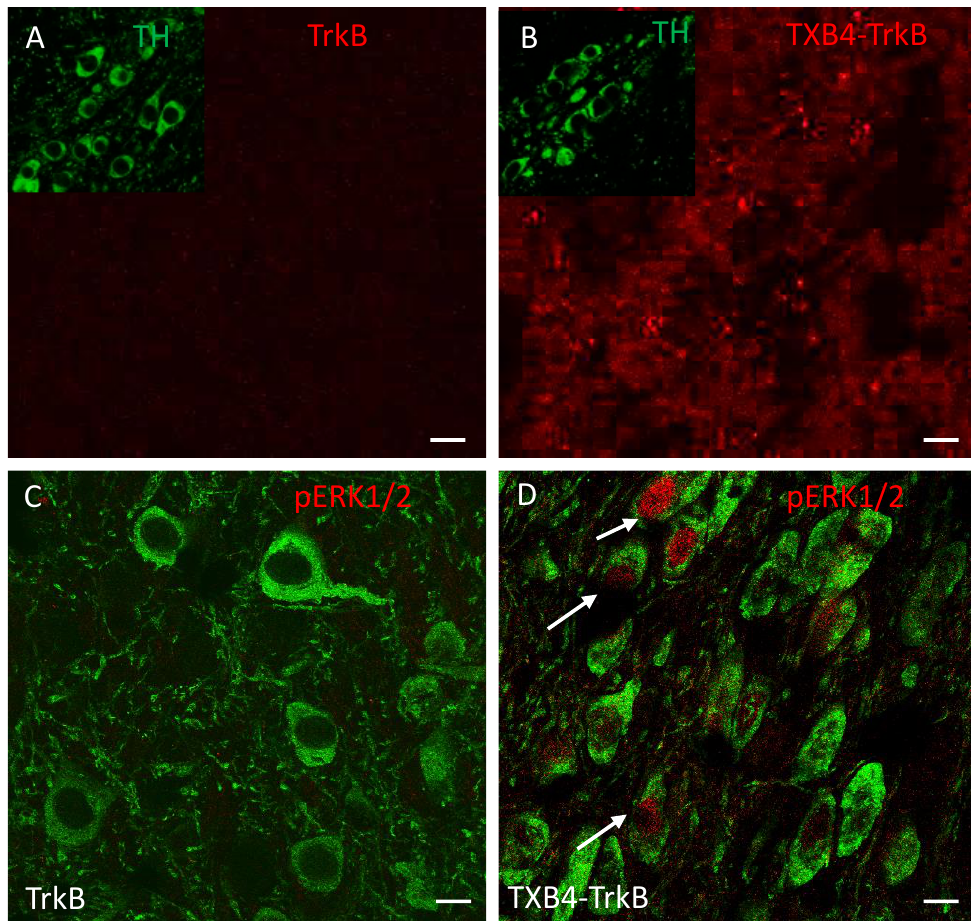
Figure 4. Localization of human IgG, TH and pERK1/2 in the SNc of animals treated with TrkB agonist antibody or TXB4-TrkB. TrkB agonist antibody or TXB4-TrkB were administered SC to mice (10 mg/kg) and brains harvested after 18 h and stained (see methods for details). Within the SNc human IgG (red) was not detected after TrkB agonist antibody administration ( A ) but diffuse and punctate staining was seen following TXB4-TrkB administration ( B ). The inserts in both show dopaminergic neurons within the same field revealed by co-staining for TH. The same regions as in A and B were also co-stained for TH and pERK1/2. pERK1/2 was not detected at high magnification (63 × ) following TrkB agonist antibody administration ( C ) but was readily detected in some cell nuclei (as indicated by arrows) following TXB4-TrkB administration ( D ). Scale bars = 10 µ